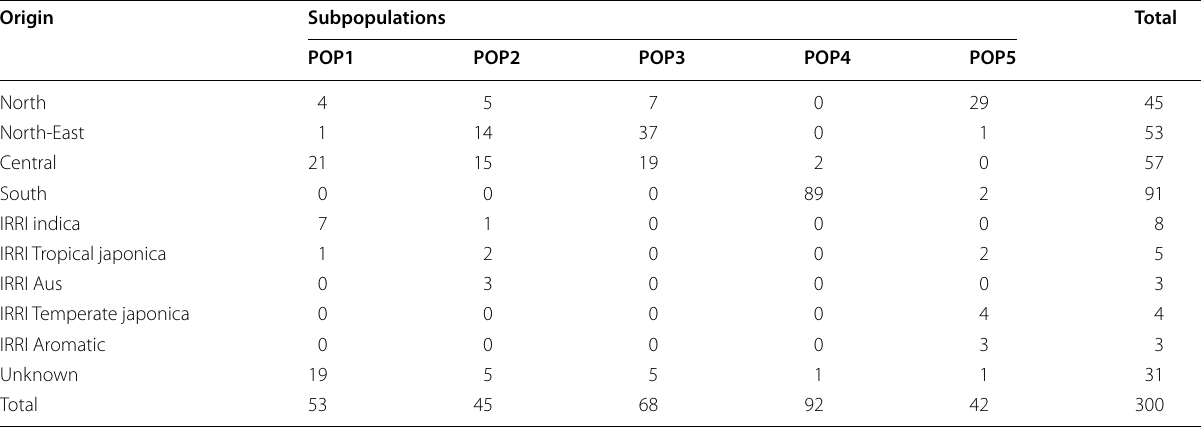
There are 246 accessions from Thai known origins (north, north-east, central, or south), 31 accessions from Thai unknown origins, and 23 accessions from